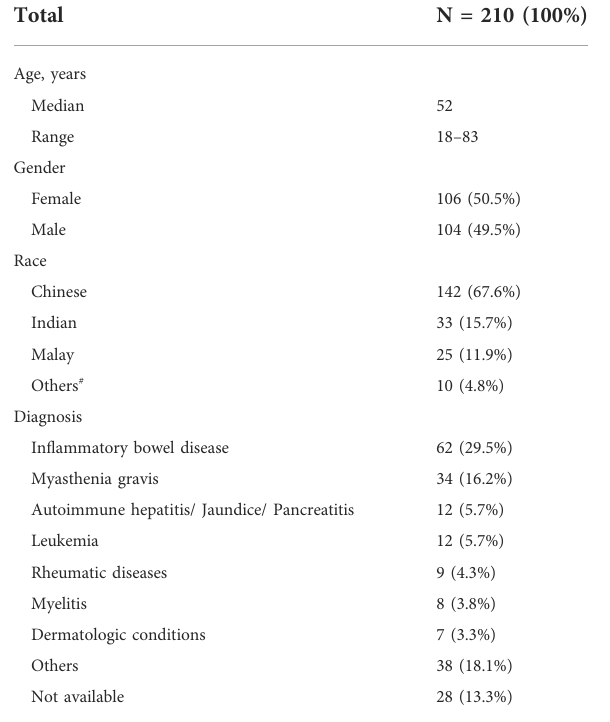
TABLE 2 Demographic information of patients.